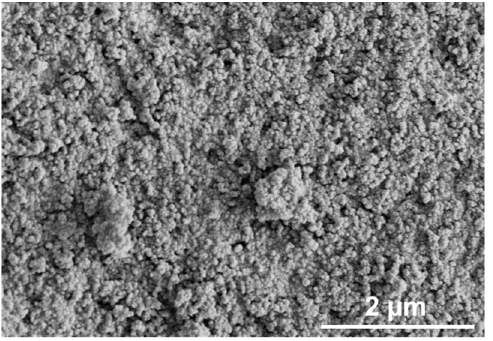
Figure 3. Scanning electron microscopy (SEM): an image of the support material Aerosil380 with a magnification of ×20,000.